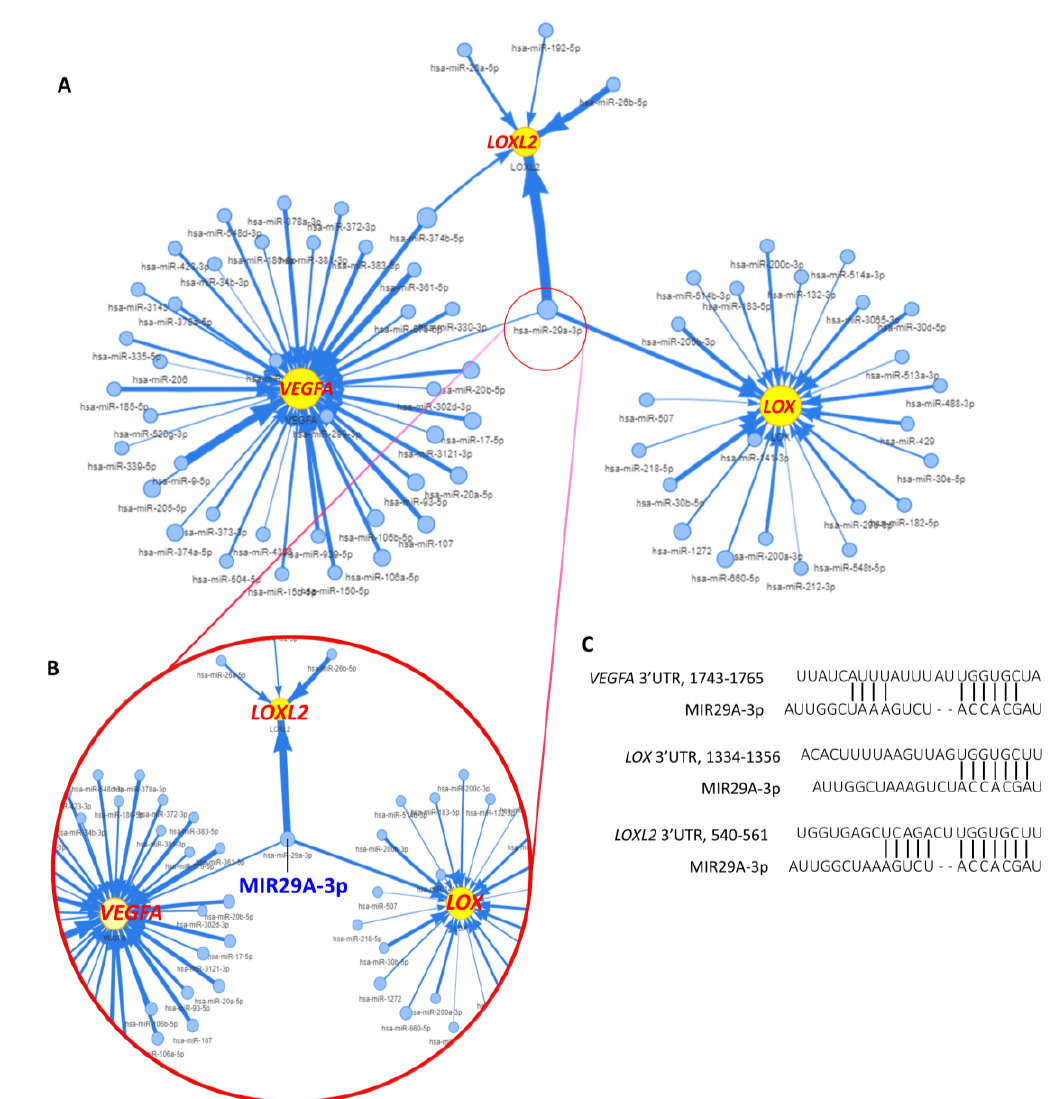
Figure 3. Bioinformatic identification of MIR29A as a common suppressor for LOX, LOXL2 , and VEGFA in HCC. ( A ) microRNA-interacting network of LOX , LOXL2 , and VEGFA in the TCGA cohort of HCC. ( B ) The enlargement of MIR29A -3p-controlled network, revealing targeted genes LOX , LOXL2 , and VEGFA. ( C ) MIR29A -3p putative binding to the 3′UTR of LOX , LOXL2 , and VEGFA were predicted by bioinformatic survey of TargetScan Release 7.2.